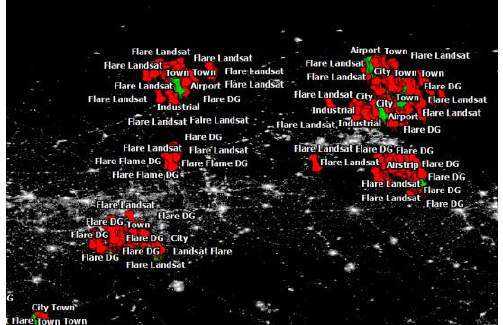
Figure 4. The possible location of the oil and gas wells marked by